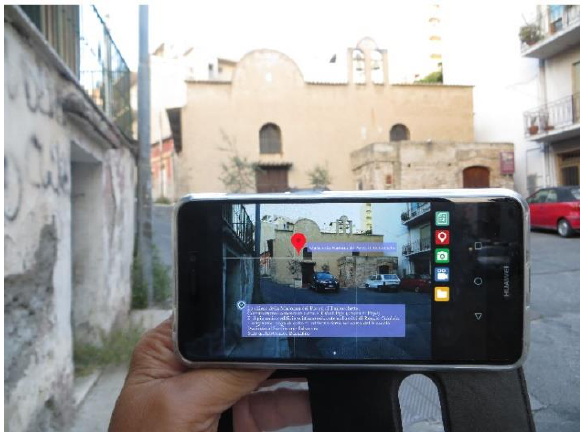
Figure 8. Augmented Reality